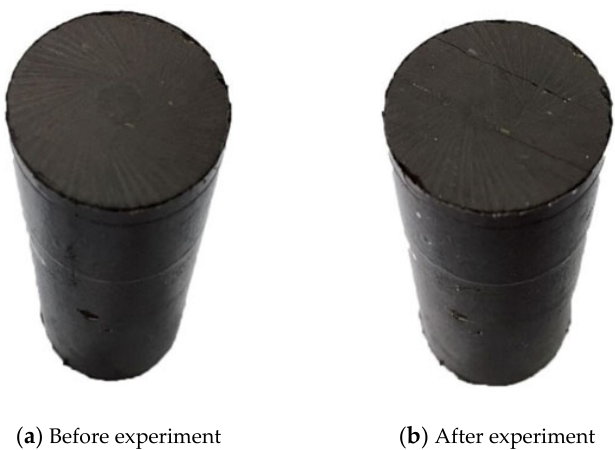
Figure 17. Comparison of macroscopic microfractures in sample S4 before and after imbibition.